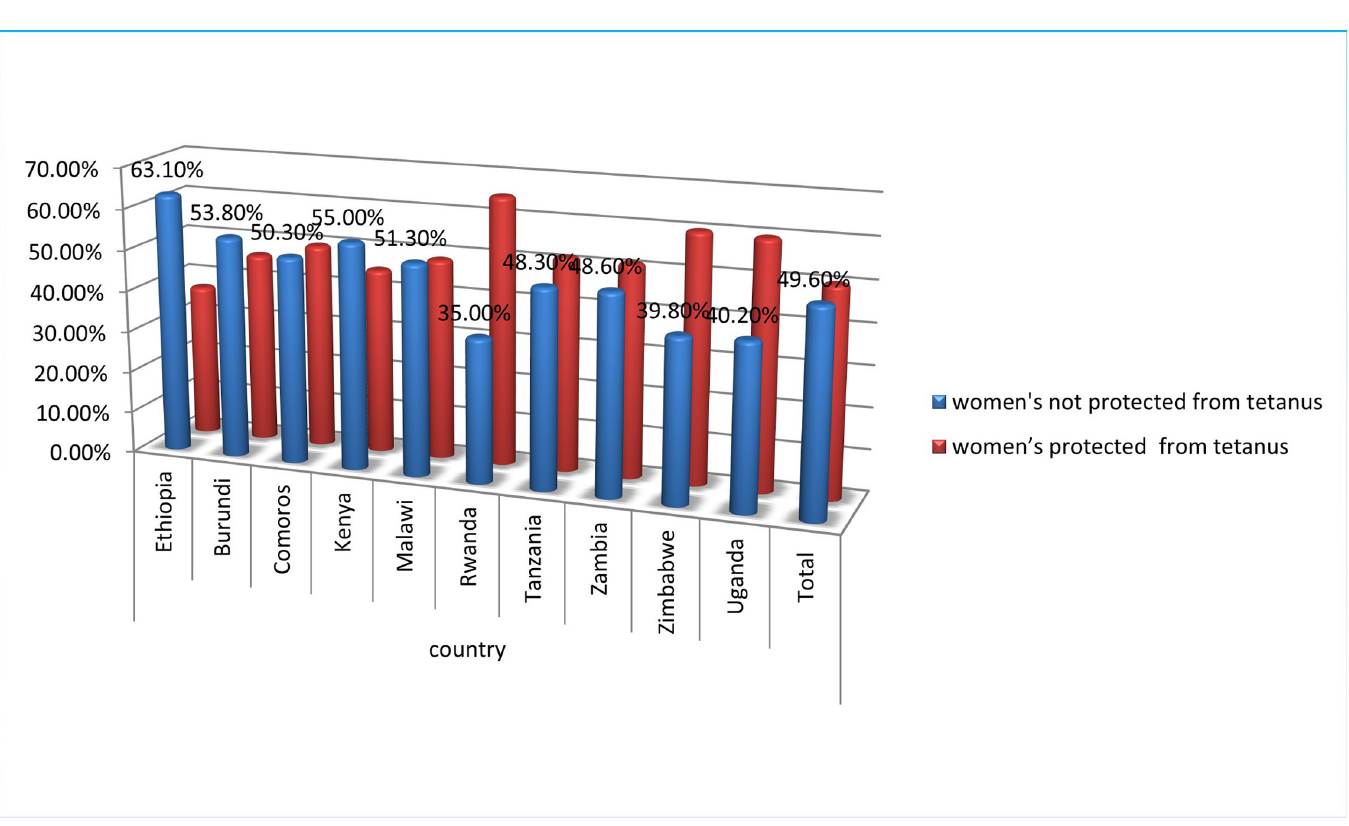
Fig 1. Percentage of protected women from tetanus before birth in East Africa (EA)